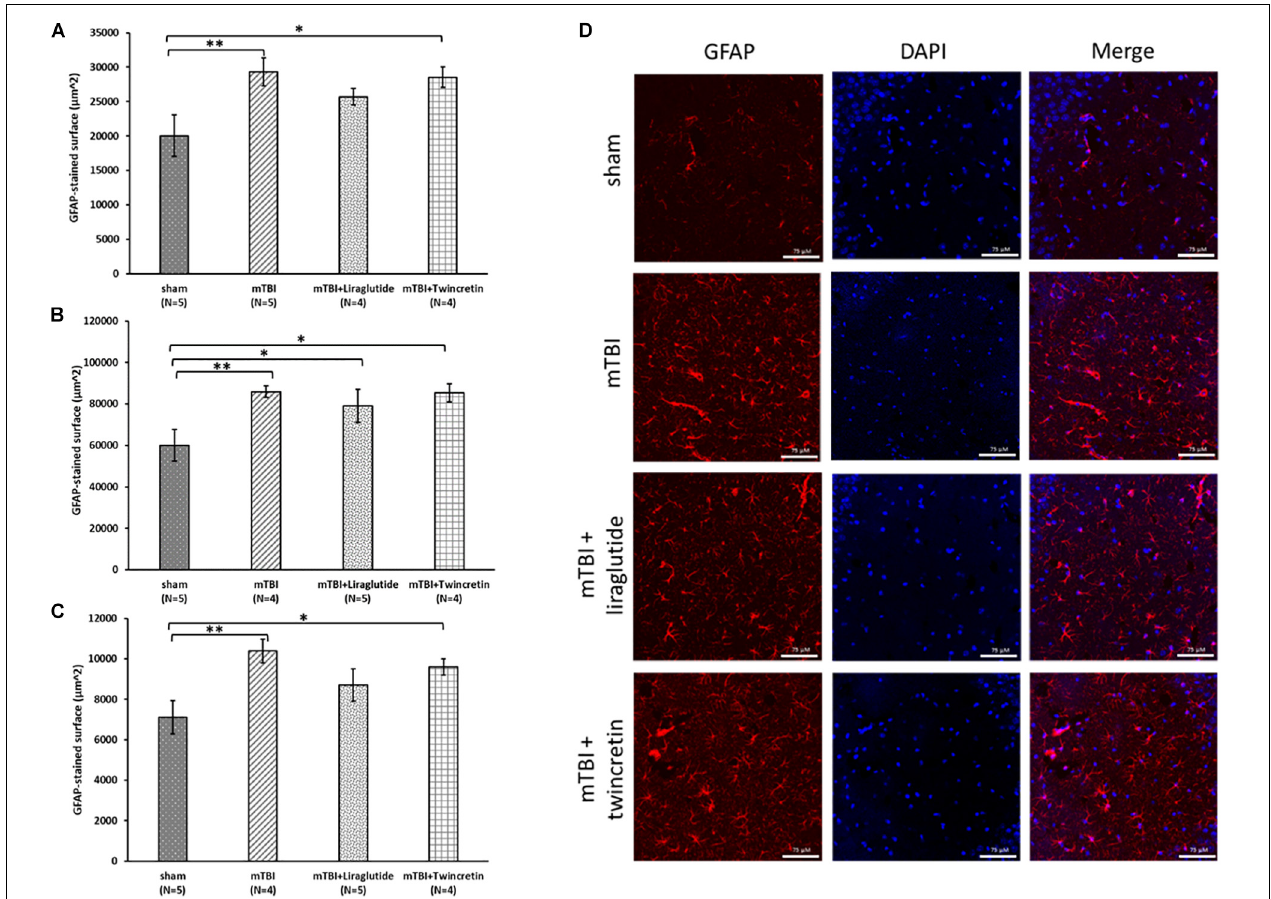
FIGURE 5 | Liraglutide and twincretin treatments do not affect the mTBI-induced elevation in reactive astrocyte expression, 72 h post trauma. Graphs presenting quantification of the total surface labeled with GFAP in the temporal cortex (A) , CA3 region (B) , and the dentate gyrus (C) . One-way ANOVA followed by Fisher’s LSD post hoc analysis revealed that mTBI induction resulted in a significant elevation in GFAP expressing cells compared to sham tissues in all regions tested [ A: F (3,14) = 3.917; p < 0.05, B: F (3,15) = 3.785; p < 0.05, and C: F (3,15) = 4.178; p < 0.05, ∗∗ p < 0.01]. Treatment with neither liraglutide nor twincretin affected this elevation as compared to mTBI. Liraglutide treatment following mTBI did not prevent the elevation in GFAP expression as compared to sham mice in the CA3 region ( ∗ p < 0.05); GFAP expression in the twincretin treatment group was significantly higher than control in all three regions ( ∗ p < 0.05). Values are mean ± SEM. (D) Representative images of immunohistochemical staining in the CA3 region are presented. GFAP positive cells are shown in red and DAPI positive cells are shown in blue. The scale bars are 75 µ